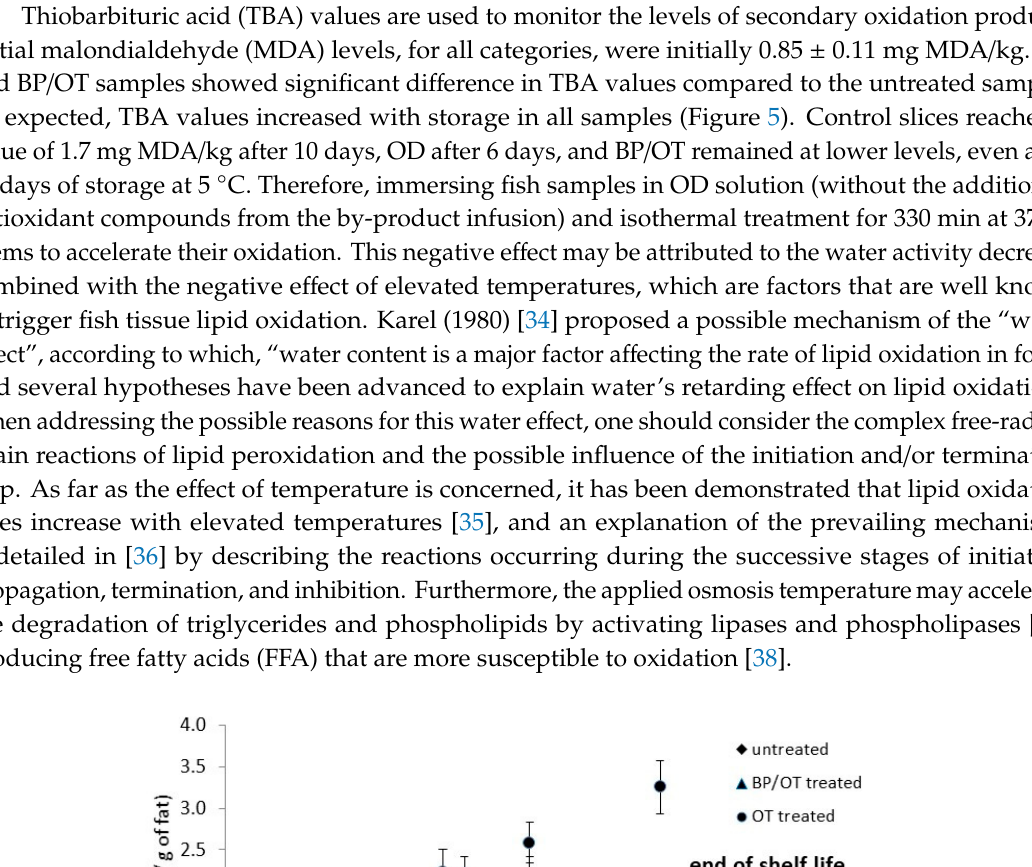
Figure 5. Lipid oxidation of fish fillets (expressed as concentration of malondialdehyde, µmol MDA/g of fat) during storage at 5 °C. Error bars represent the ± standard deviation of measurements. 3.4.3. Shelf Life Determination Regarding shelf life determination, the total lipid content of the studied cultured sea bass samples was determined, giving an average fat content of 5.2%. Assuming as acceptable a lipid oxidation level at the end of the shelf life being at 8 mg MA/kg fish flesh [44], and the estimated limit of 2.1 µmol MA/g of fat, one could graphically roughly estimate fish shelf life after the alternative treatments, namely 14 days for the untreated samples, 10 days for the OT-treated samples and a significantly longer time period (hardly distinguished by the plot) for the BP/OT-treated samples. Similarly, if the acceptability limit was set based on microbial spoilage and assumed to be equal to total viable count, reaching a level of 10 7 cfu/g (estimated when fish was organoleptically rejected by a preliminary sensory test and also reported in [25], for untreated (control) and OD-treated Sparus aurata fillets) with the incorporation of antimicrobial agents in the osmotic solution; then, the fish fillet shelf life could be estimated using the following equation (Equation 3), according to [14,28]: t SL = t l ag +(log N t -log N o )/ k (3) where N t and N o are the final (limit of acceptability) and the initial microbial population, t lag is the lag phase, and k is the relative growth rate (Table 1). Therefore, their shelf life was found to be 5 days for the untreated samples, 9 days for the OT treated samples, and 11 for the BP/OT-treated ones. According to [28], the addition of carvacrol and glucono- δ -lactone in a maltodextrin/NaCl osmotic solution posed additional hurdles to microbial growth in gilthead sea bream fillets, especially at low storage temperatures (0–5 °C). In [45], the authors investigated the antioxidant and antimicrobial effect of rosemary essential oil EO and extracts by incorporation in a carboxyl